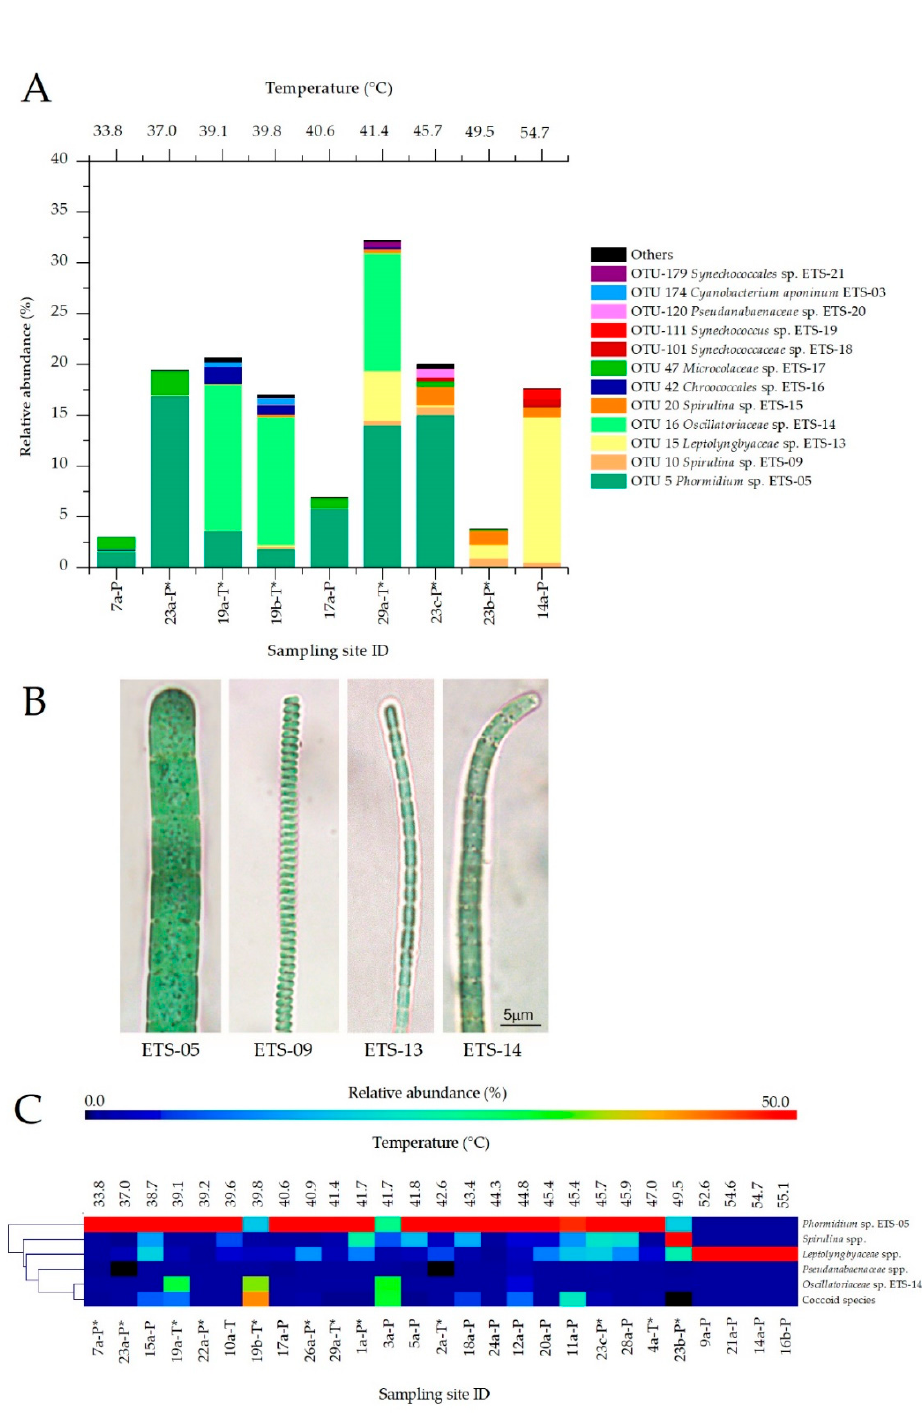
Figure 5. ( A ) Relative abundance of the main Cyanobacteria operative taxonomic units (OTUs) identified by next-generation sequencing (NGS) analysis; species having abundance lower than 0.5% were indicated as “Others”. ( B ) The main Cyanobacteria species identified by microscopy observations: Phormidium sp. ETS-05, Spirulina sp. ETS-09, Leptolyngbyaceae sp. ETS-13 and Oscillatoriaceae sp. ETS-14. ( C ) Heatmap showing the relative abundance of main Cyanobacteria taxa identified from light microscopy observations and calculated from 16S rRNA amplicon sequencing. From left to right, results are represented as a function of increasing temperatures. Samples collected from maturation systems provided with protective roofs are indicated with *.